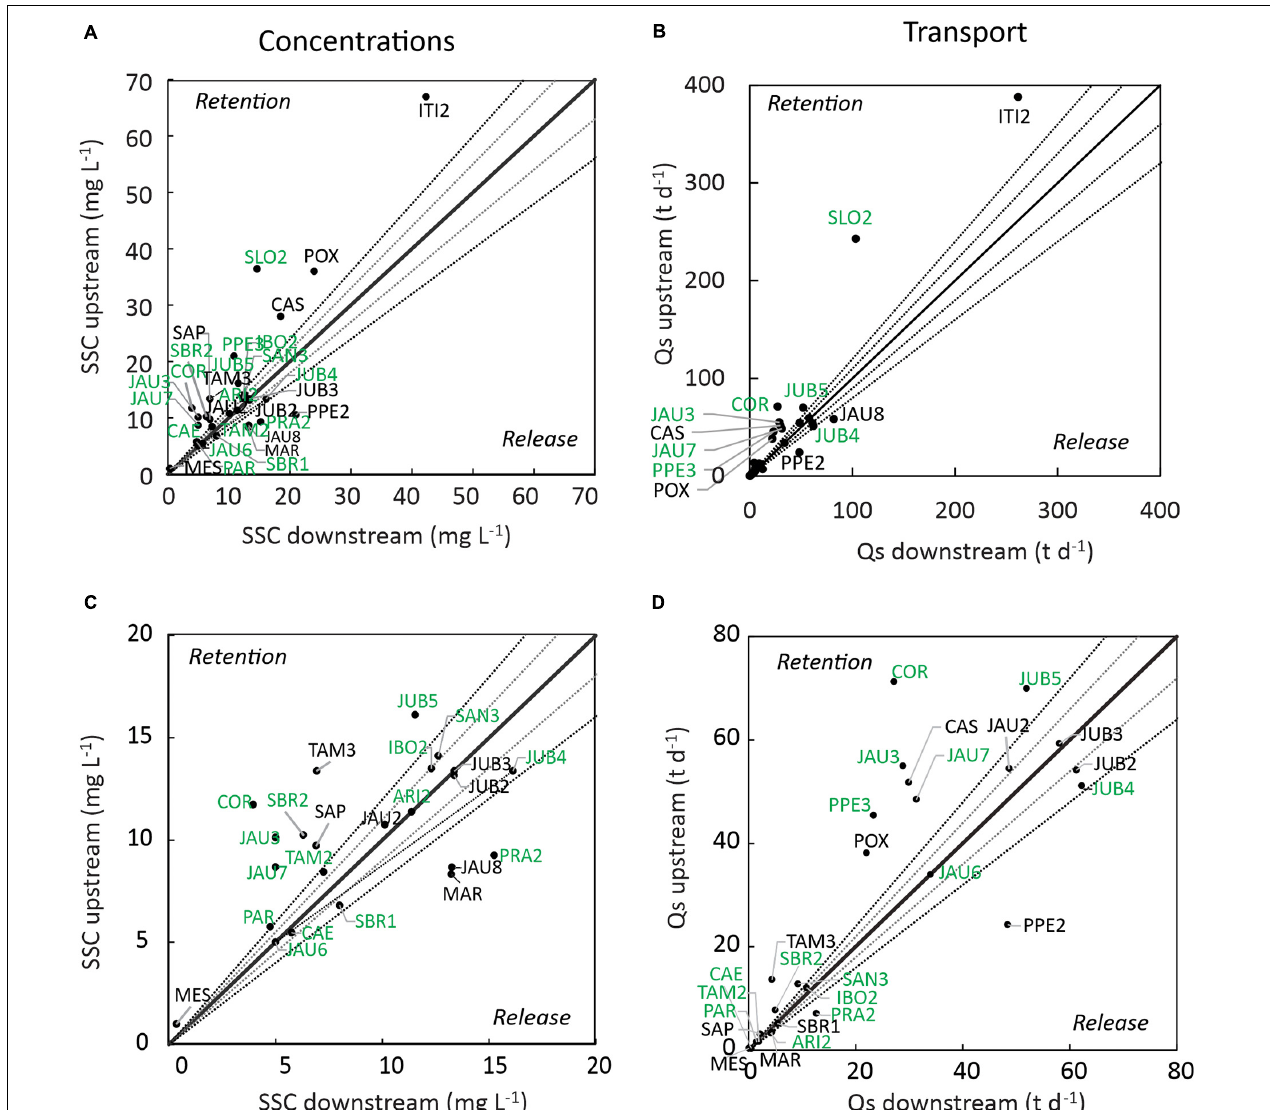
FIGURE 4 | Comparisons of changes in water-column concentrations (SSC) and transport (Qs) of suspended sediments between upstream and downstream of current hydroelectric facilities based mainly on primary data collected in this study as well as some secondary data. (A,B) All data on concentrations and transport, respectively; (C,D) the same data with high values excluded. Solid line shows the line of parity and dashed lines show bounds of ± 10 and ± 20% around that line; points above the line indicate net retention and those below indicate net release between the upstream and downstream sampling points. Upstream:downstream ratios that deviate considerably from 1:1 are identified with the codes shown in Table 1 ; codes in green font indicate cases where the statistical analysis of the changes across all individual sampling dates showed significant ( p < 0.05) differences from zero.